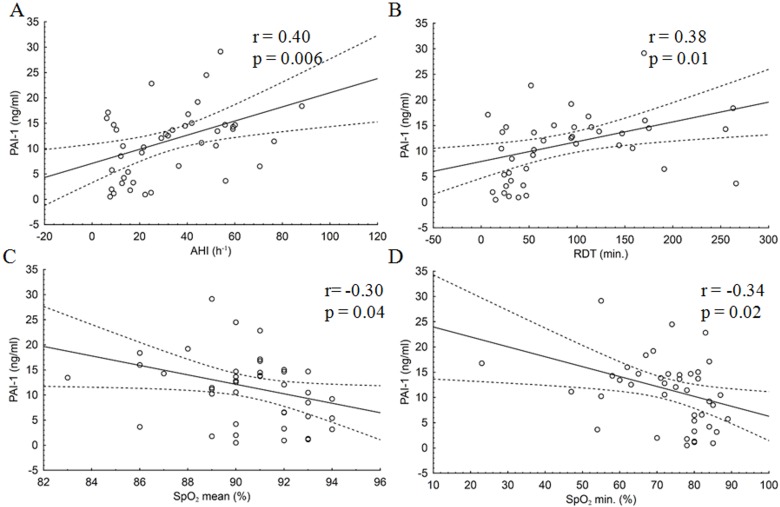
Correlations between selected polysomnographic parameters and PAI-1 concentration in patients with OSA.Breathing disorders during sleep were identified by polysomnography, which was taken at night, from 22:00–23:00 to 05:00 a.m. To diagnose and grade the severity of obstructive sleep apnoea, the number of apnoeas and hypopnoeas per hour was reported and the apnoea-hypopnoea index (AHI) calculated. Correlations between PAI-1 concentrations and polysomnographic parameters: (A) AHI, (B) RDT, (C) SpO2 mean, (D) SpO2 min. r and p values were calculated by Spearman’s rank order correlation test.